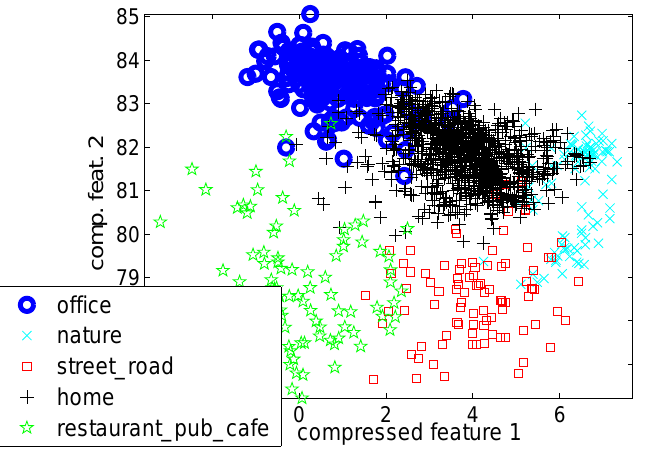
Figure 5. Two main features after the feature